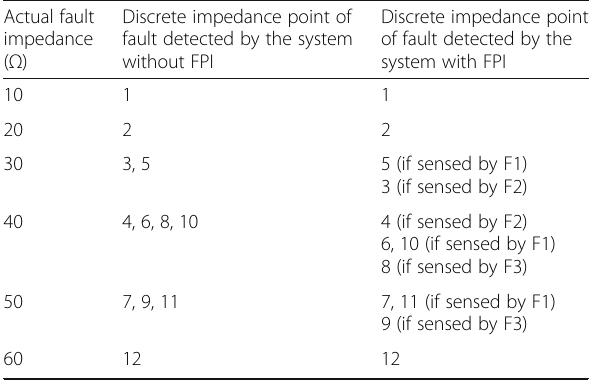
Discrete impedance point of fault detected by